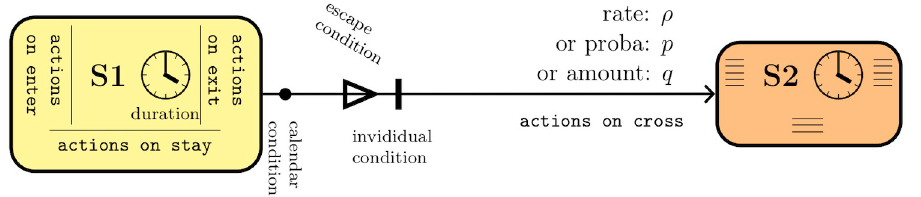
Fig 2. Structure of a transition between two states in state machines. Individuals can be given a duration and actions when entering, staying in, or leaving the state. Transitions feature a rate, probability, or amount, and can be associated with actions performed on crossing, time-dependent ("calendar") conditions, or individual conditions restricting the capability to cross the transition, and escape conditions allowing individuals to leave their state before the nominal duration.